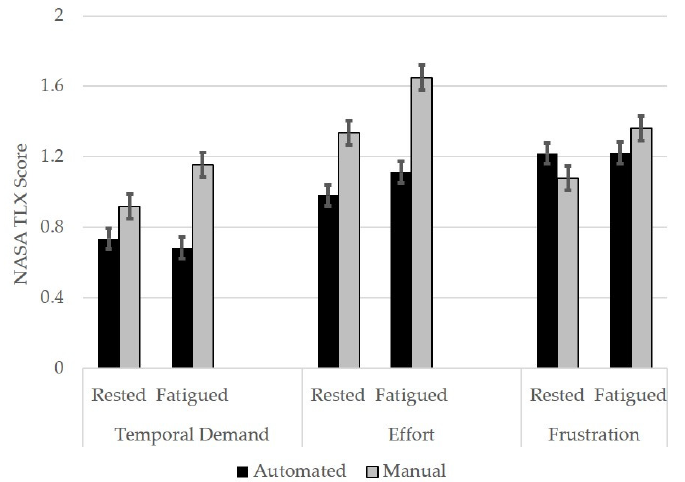
Figure 2. Effects of automation on drivers’ workload in rested and fatigued conditions. Error bars indicate SD.